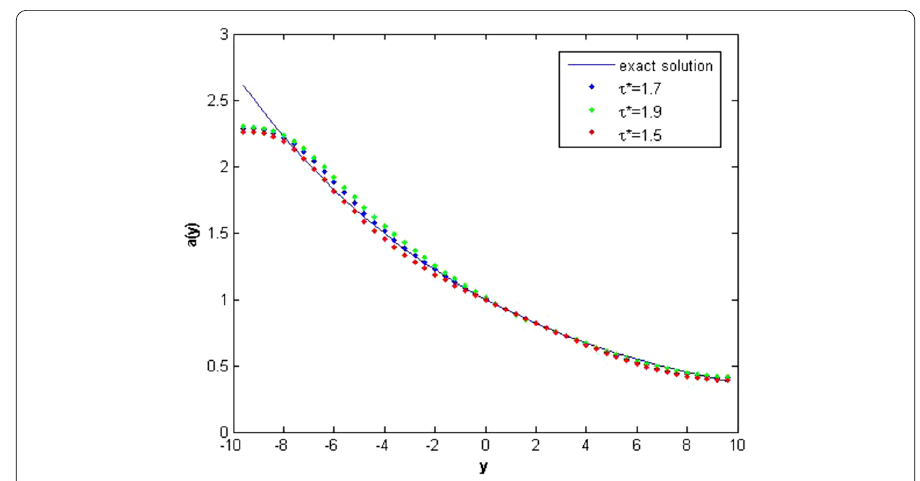
Figure 7 Noiseless case for Example 3, where r = 0.09 and σ =